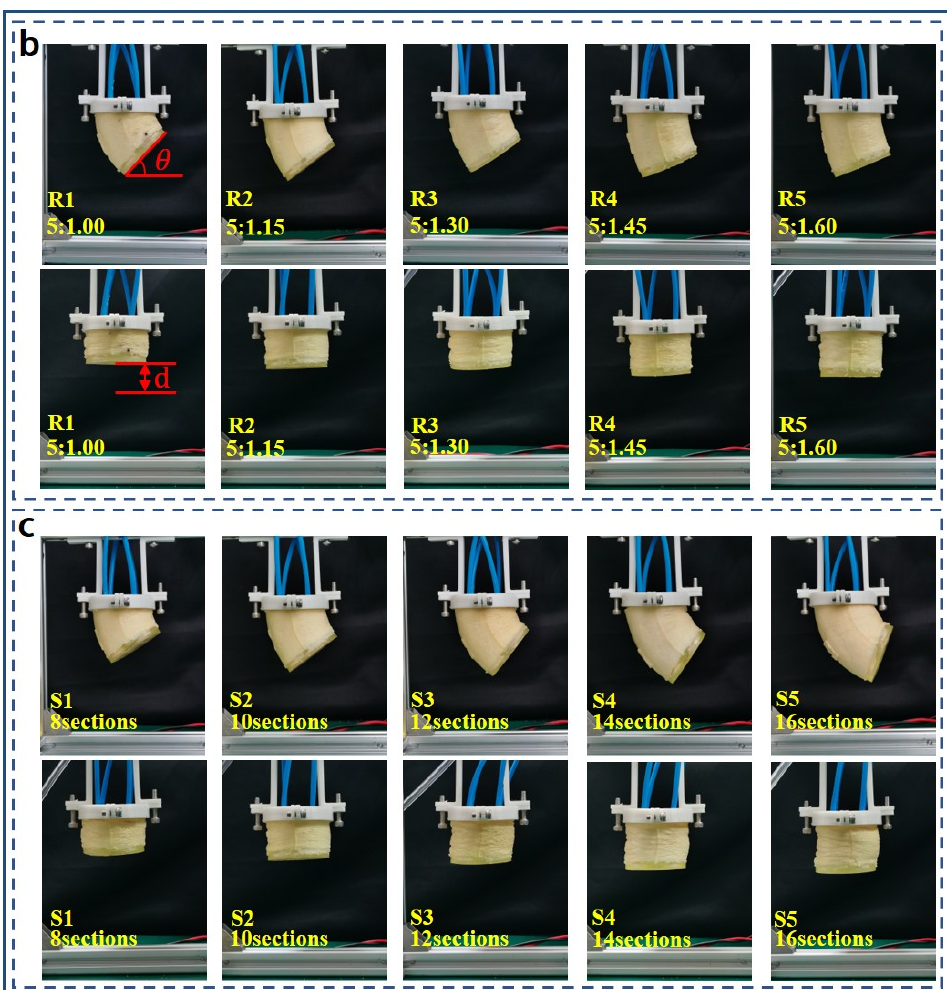
Figure 5. Actuator motion characteristics test: ( a ) Bending and contraction testing device. Bending and contraction at 90 kPa with ( b ) different foaming ratios and ( c ) different actuator lengths. ( θ and d are introduced in Section